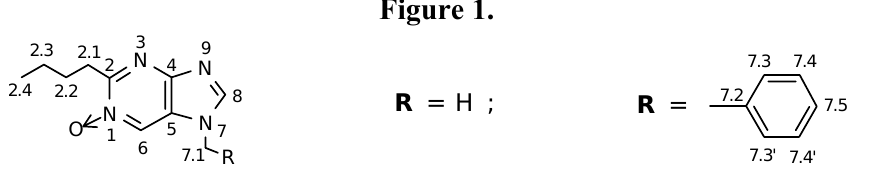
*, 200 MHz); calculated data in parentheses. 3